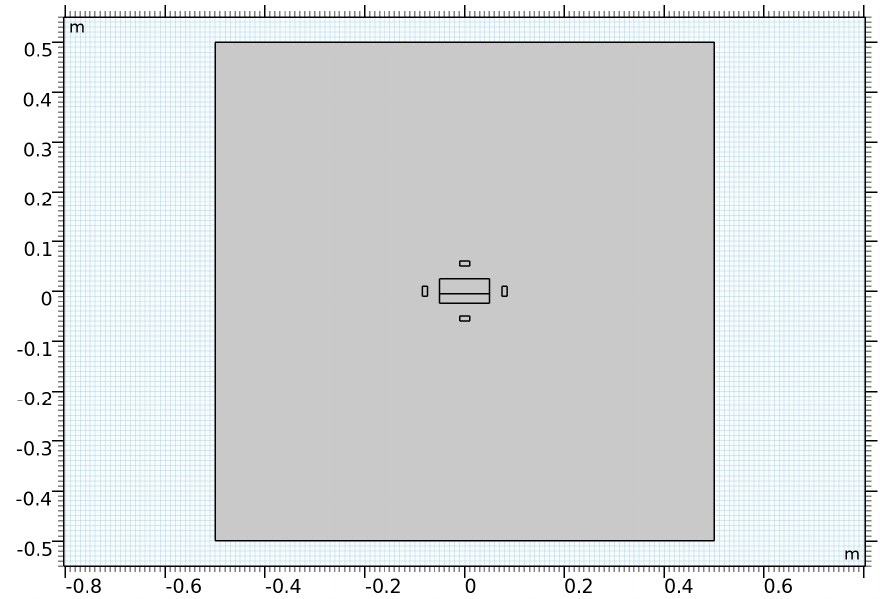
Figure 4. Harvester and the large domain surrounding it.